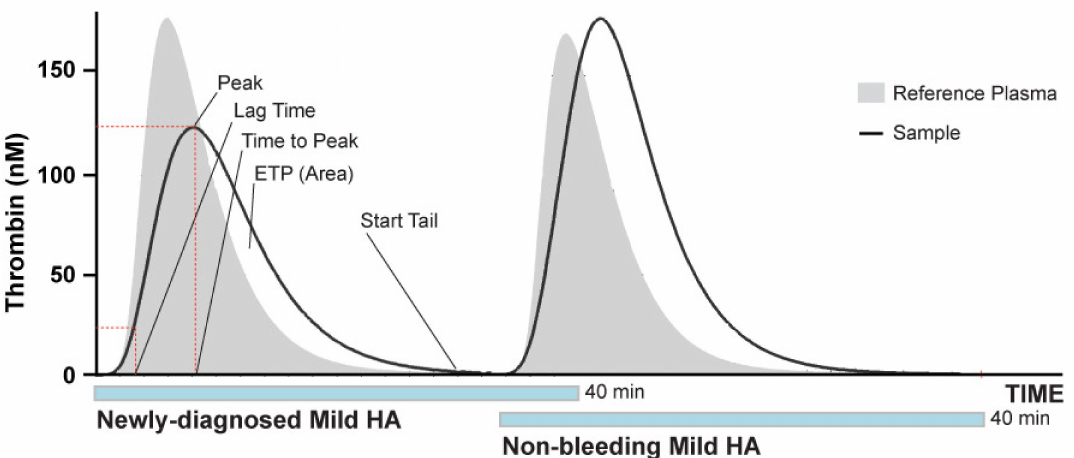
Figure 1. Schematic representation of TGT curves generated by the ST Genesia ® . Representative graphs of TGTs from samples obtained from mild HA patients, a newly diagnosed patient (left), and a previously diagnosed patient without current bleeding symptoms (right). The TGT variables are